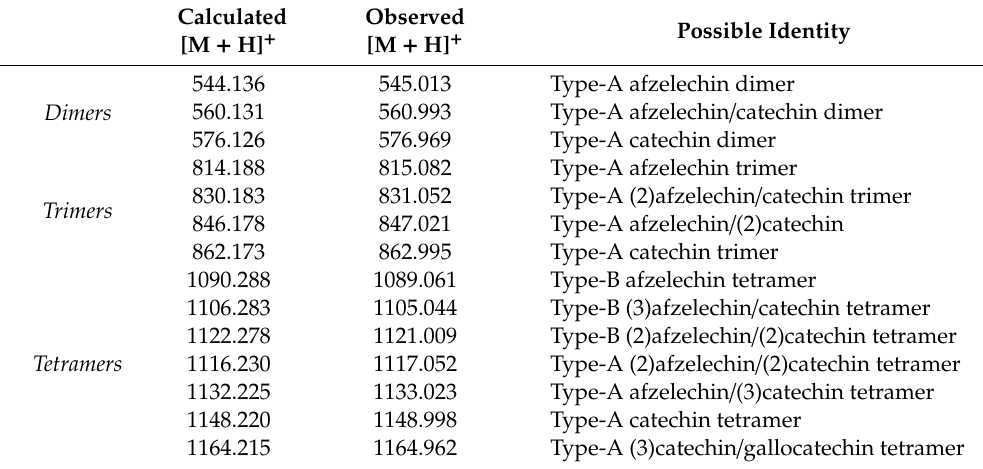
Table 2. Insoluble-bound proanthocyanidin composition from guarana powder ( Paullinia cupana ) a .